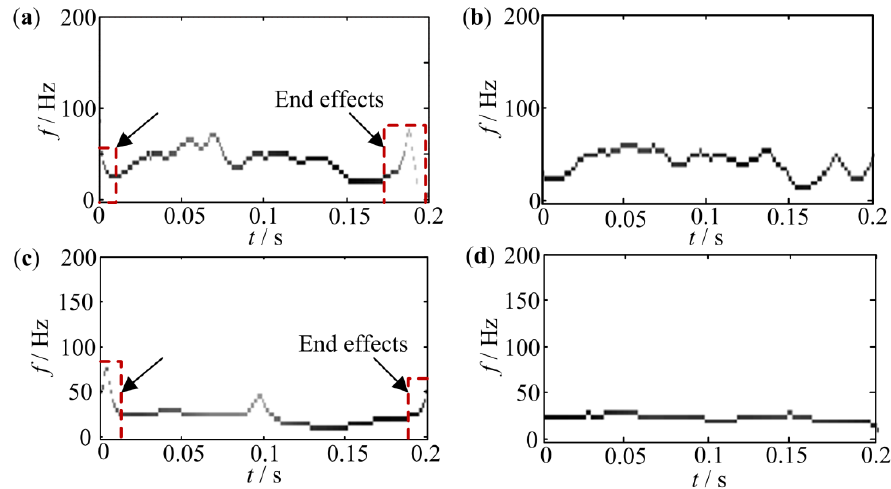
Figure 8. The Hilbert spectrum for the IMF5 of the normal pressure signals using ( a ) EMD2 and ( b ) EMD3, and the Hilbert spectrum for the slight degradation pressure signals using ( c ) EMD2 and ( d ) EMD3.